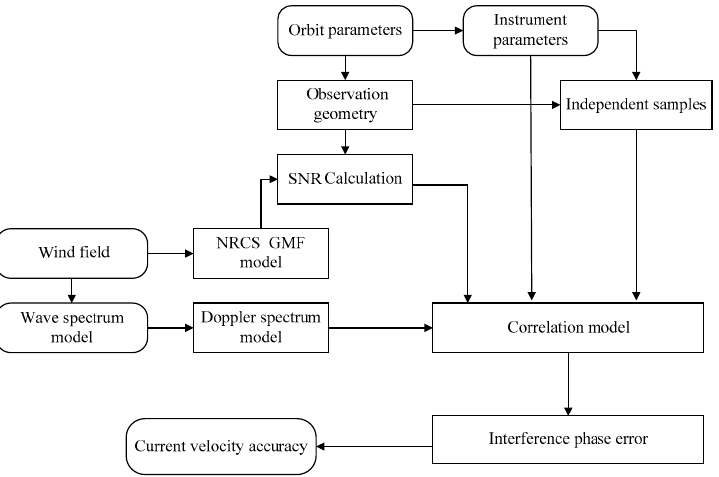
Figure 14. End-to-end system simulation model diagram.